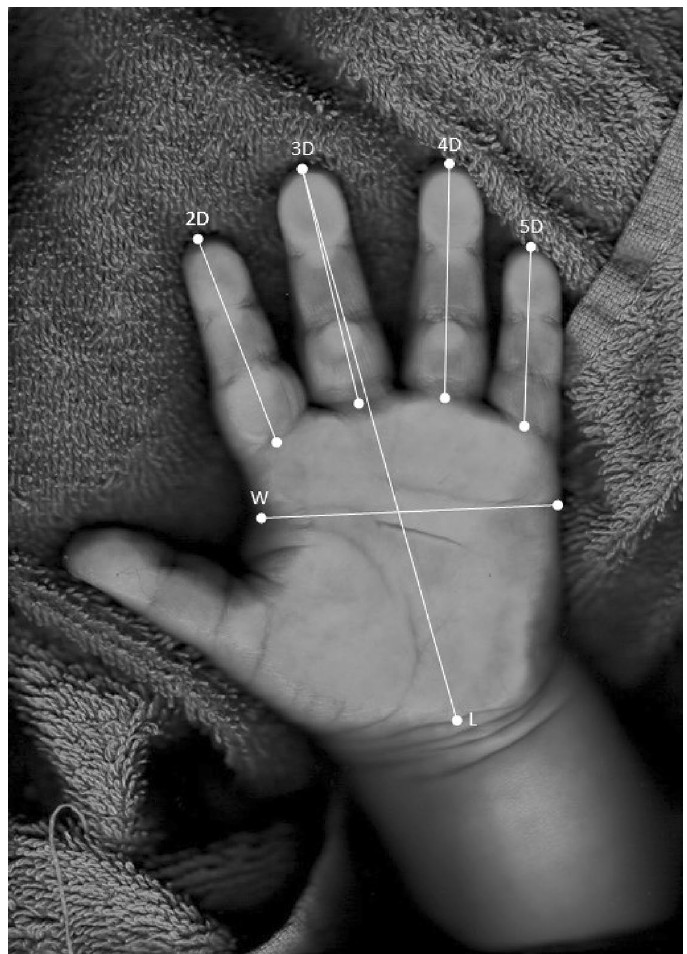
Figure 1. Example measurement of digit lengths (2D, 3D, 4D, 5D) and hand width (W) and length (L) using the freeware program AutoMetric 44